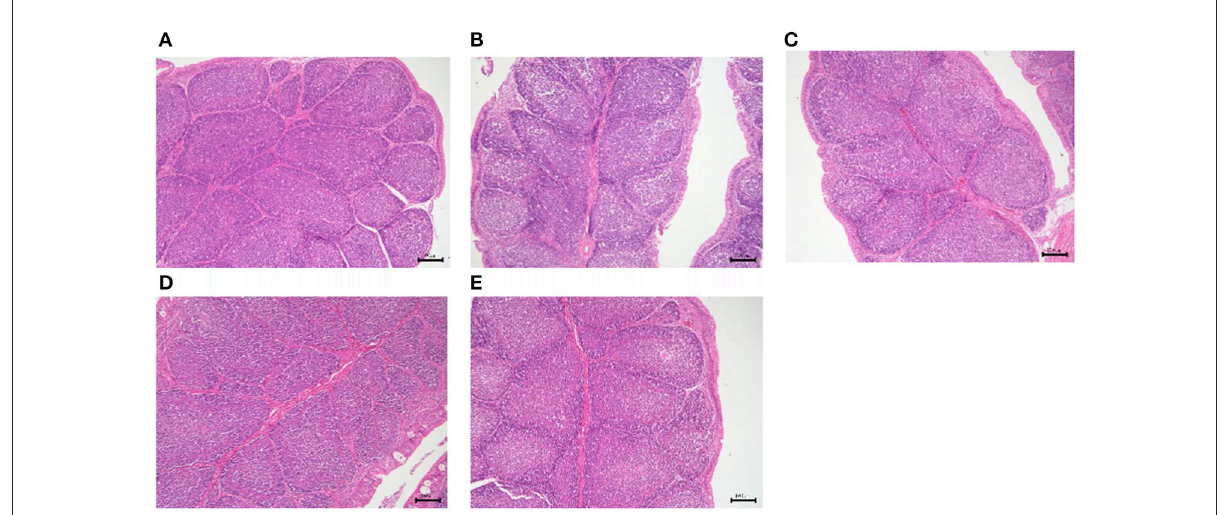
FIGURE11 Histological changes of the bursa of Fabricius in each group. (A) GPS-1L group; (B) GPS-1M group; (C) GPS-1H group; (D) VC group; (E) BC group. H&E staining; 200 ×